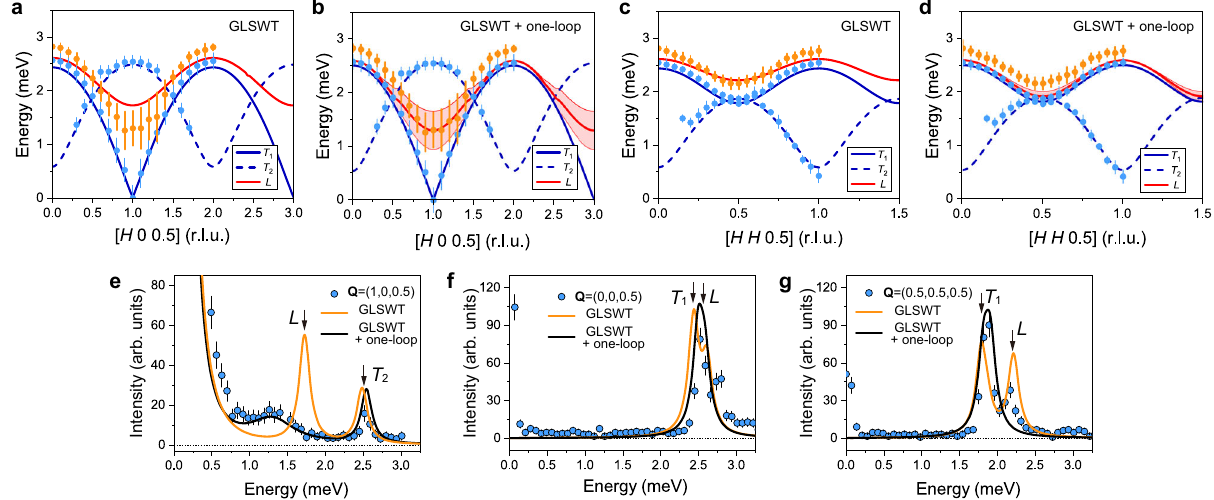
Fig. 7 Comparison between measured and calculated spectrum. Comparison of the measured and calculated dispersion along the [ H , 0, 0.5] ( a , b ) and [ H , H , 0.5] ( c , d ) directions. In all panels of this fi gure, the theoretical results are obtained for the parameter set B in Table 1. a – d Blue and orange fi lled circles indicate the measured transverse and longitudinal modes, obtained from the Gaussian fi tting to the data shown in Fig. 4a. Dots and error bars indicate peak centers and full width at half maxima (FWHM) of the observed modes, respectively. Lines indicate the calculated dispersions obtained from the GLSWT and GLSWT + one-loop corrections. The red-shaded region in b and d depict the decay (line broadening) of the longitudinal mode given by the one-loop corrections. e – g Comparison between the measured (blue dots) and calculated (orange and black lines) INS intensities at three high-symmetric Q -points at (1, 0, 0.5), (0, 0, 0.5), and (0.5, 0.5, 0.5). All the experimental data were measured using CTAX with fi xed E f = 3 meV. For GLSWT, two transverse and longitudinal modes are denoted with T 1 , T 2 , and L